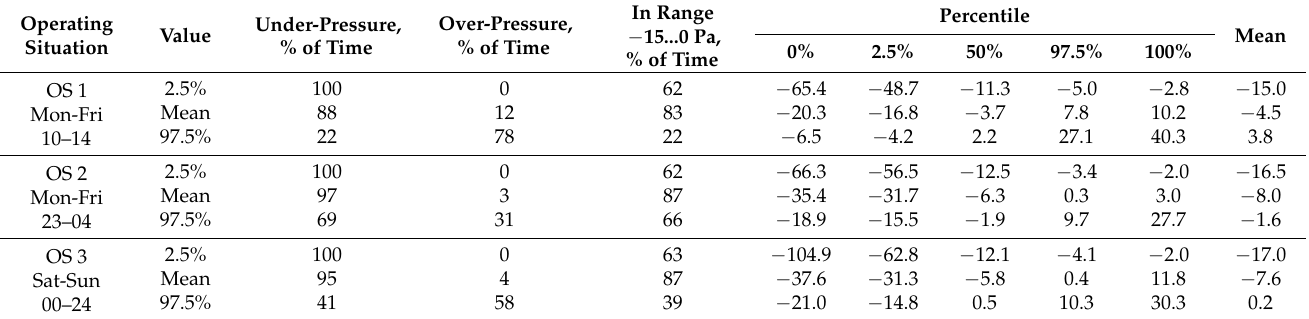
Table 3. Descriptive statistics on the air pressure differences for different operating situations. The total number of measurement points was n = 100.